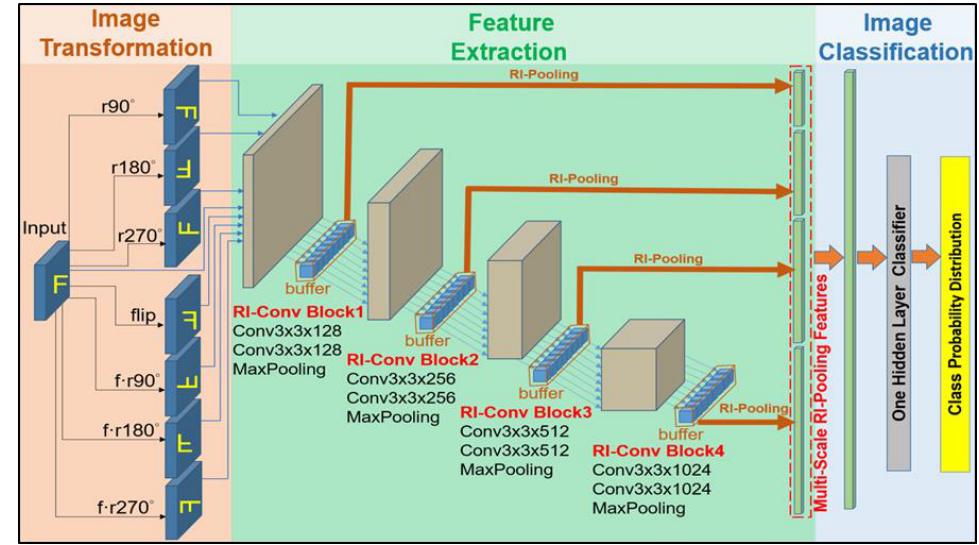
Figure 5. Proposed RIMS-CNN model.